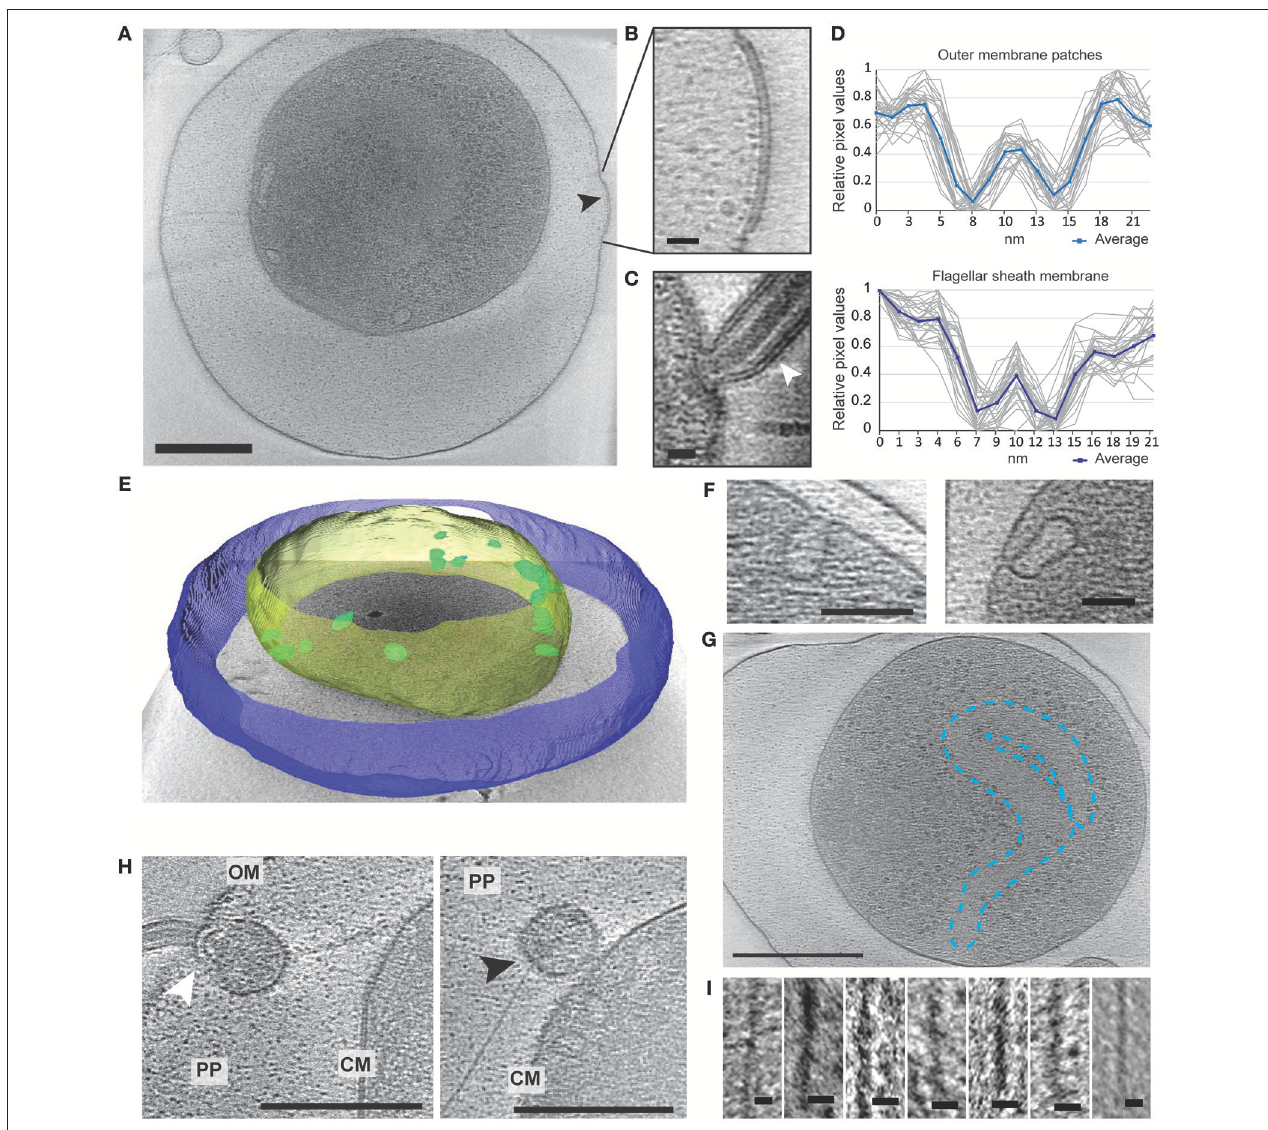
FIGURE 2 | Structural changes of VBNC cells as observed by ECT. (A) A cell from a NBW microcosm with a convex OM patch (black arrow). (B) Magnified detail of A exhibiting the pronounced two layers of the OM patch. (C) Flagellar sheath membrane (white arrow) for comparison. (D) Individual (gray) and averaged (blue) line scan measurements perpendicular to the membrane exhibit similar spacing of the two layers in the outer membrane patch (upper panel) and flagellar sheath membrane (lower panel). (E) Tomogram of a NBW VBNC cell segmented using Amira. Outer membrane (blue) is clearly separated from the cytoplasmic membrane (yellow). Multiple invaginations (green) can be found lining the cytoplasmic membrane. (F) Examples of the invaginations found in VBNC cells from NBW (left panel) and NSW (right panel) microcosms. (G) Tentative outline highlighting the condensed chromosomal DNA. (H) VBNC cells showing flagella (left panel, white arrow) or T4P (right panel, black arrow) embedded in small vesicles. (I) Details of exemplary T4P. Scale bars represent 200nm (A,G) , 100nm (H) , 50nm (F) and 10nm (B,C,I) , respectively. CM, cytoplasmic membrane; PP, periplasm; OM, outer